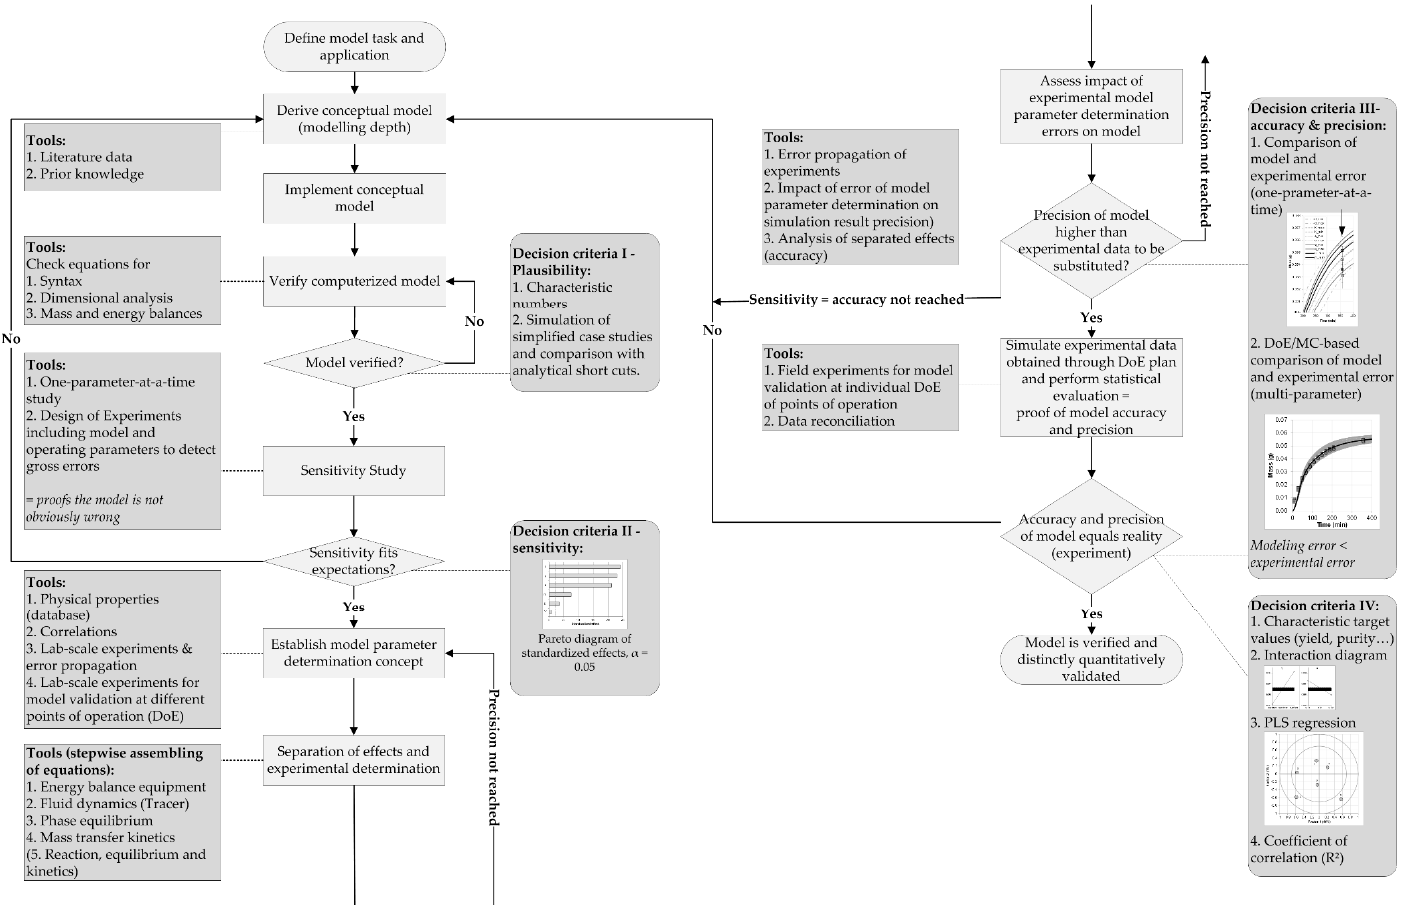
Figure 1. General valid model validation workflow [13]. Macroscopic kinetic models simulating the dynamic state of a cell culture can gather essential information about cellular conditions (e.g., lag, exponential, stationary, decline phase), substrate uptake, metabolite, and productivity, as well as possible feeding adjustments [14–19]. A combination of online turbidity data resembling the cell concentration and a macroscopic kinetic model was already applied to estimate substrate and metabolite concentrations [11]. A general overview of several working groups focusing on upstream process modelling is presented in Table 1. DoE, design of experiments; MC, Monte